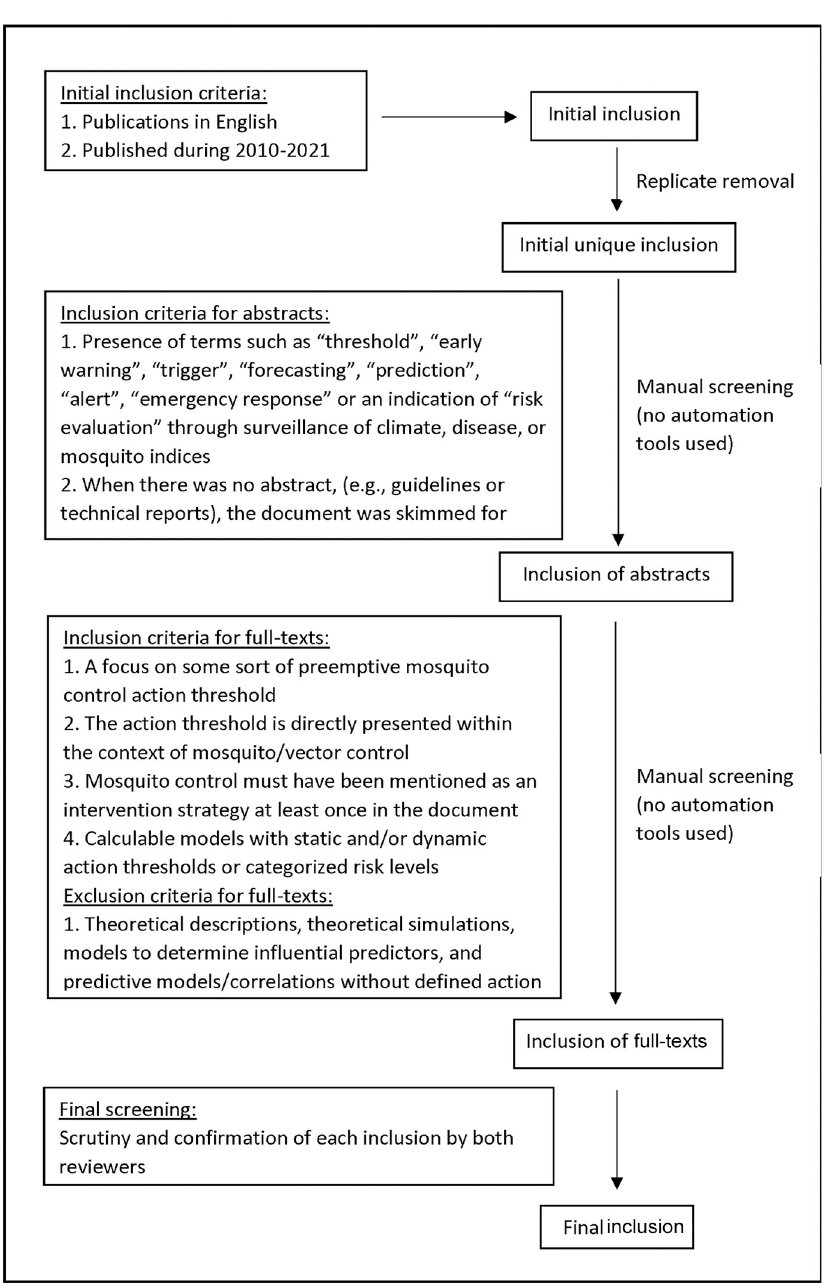
Fig 1. Search process and inclusion/exclusion